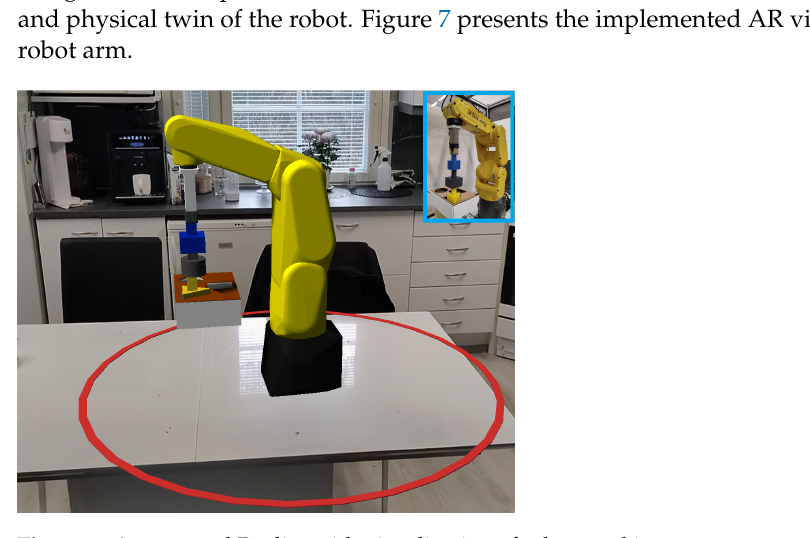
Figure 7. Augmented Reality with visualization of robot working